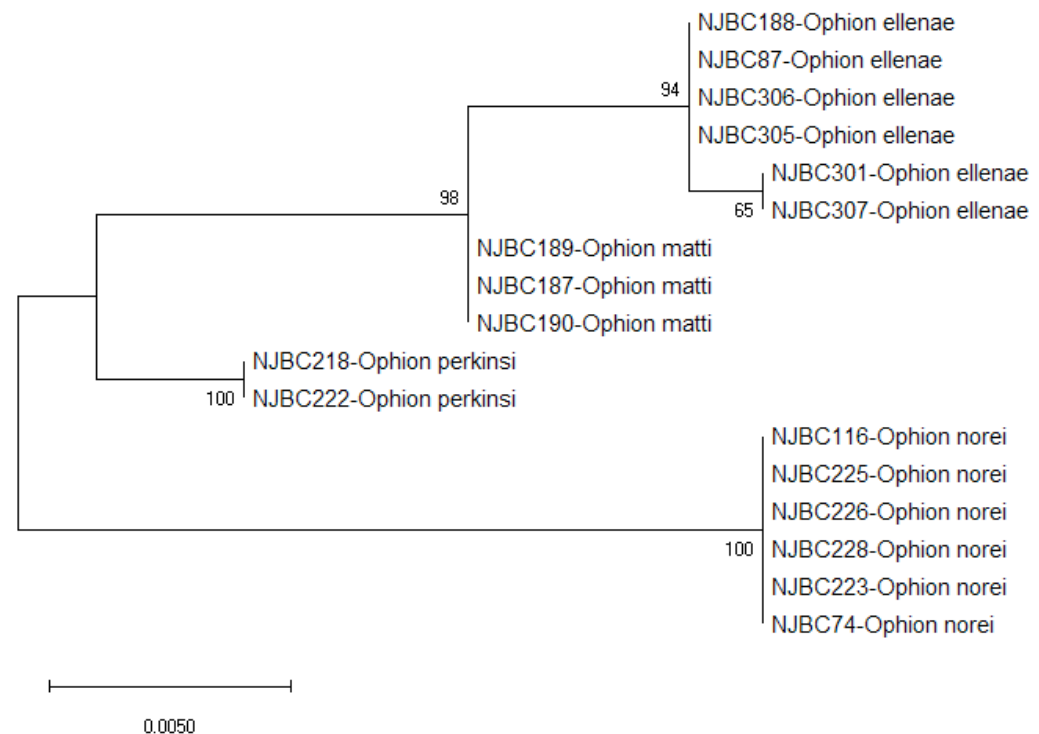
Fig. 4. Phylogeny of the Ophion perkinsi aggregate (BIN. BoLD: ADM6556) as obtained from cytochrome oxidase 1 (CoI) sequences. Maximum likelihood tree is shown with clade support based on 150 bootstrap iterations using the general Time reversible model and analysed with MEgA-X. The sample ids “NJBC” refer to the BoLD